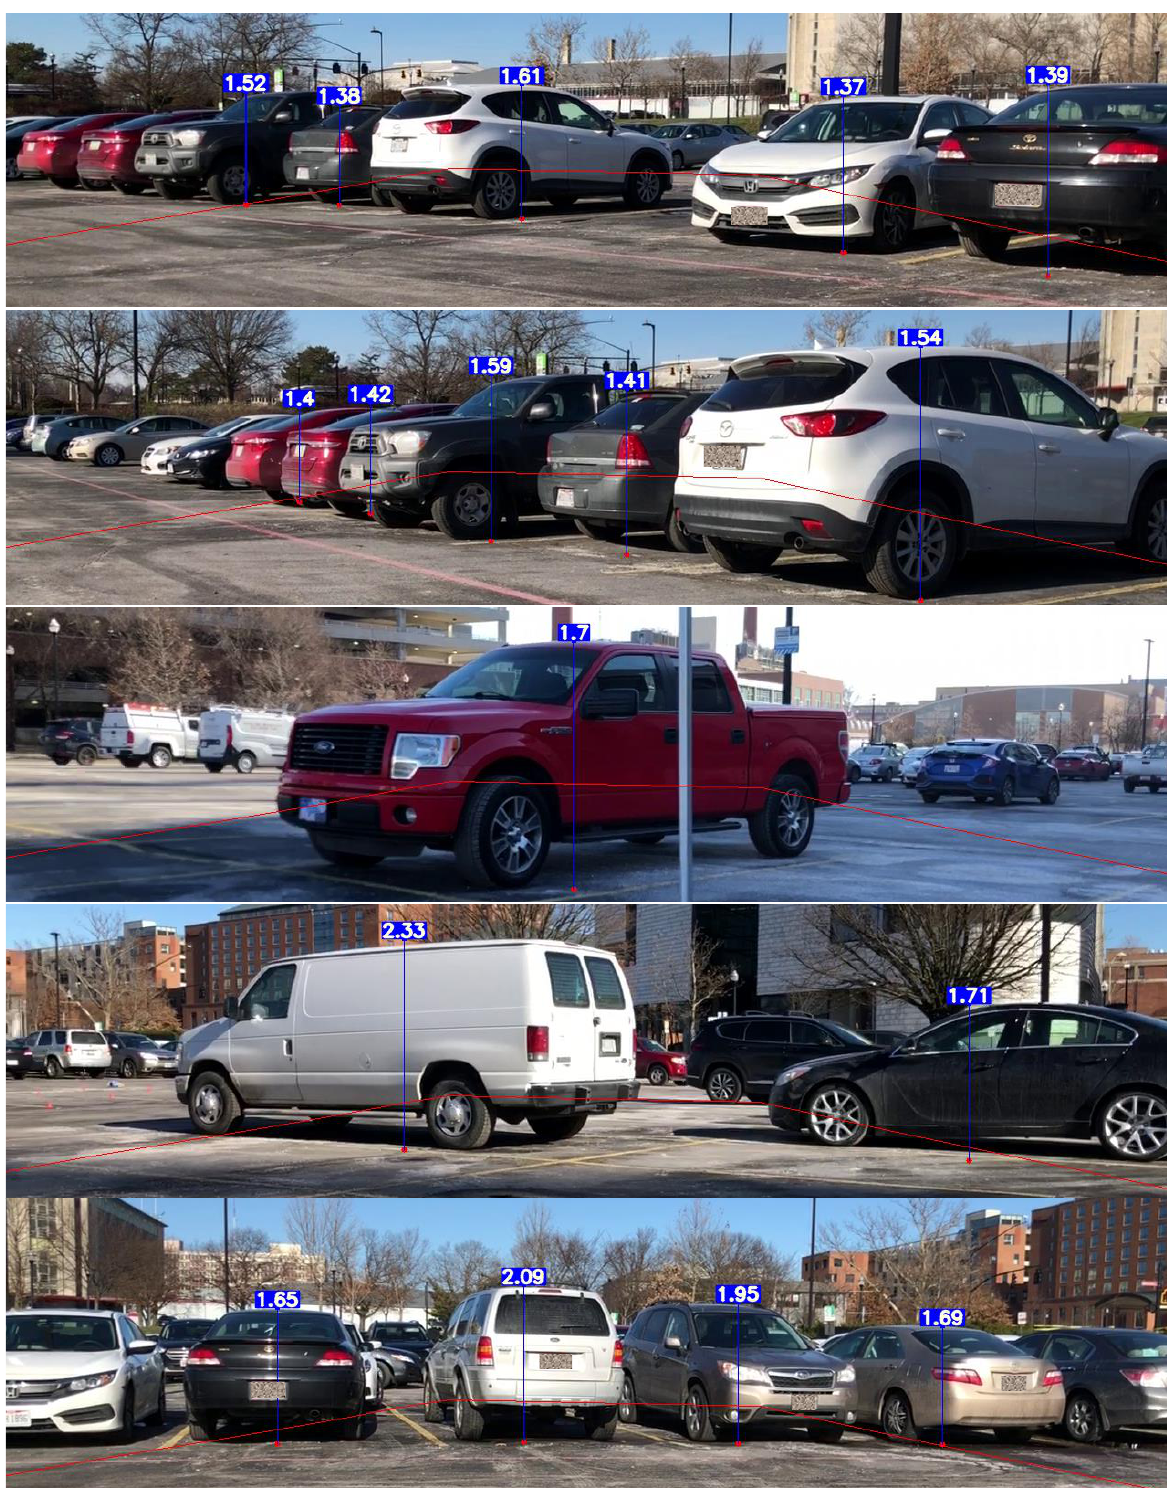
Figure 13. Platform moves and objects within the red polygons are estimated height. Heights are also displayed in the blue boxes in meters, matching judgements we made on vehicles